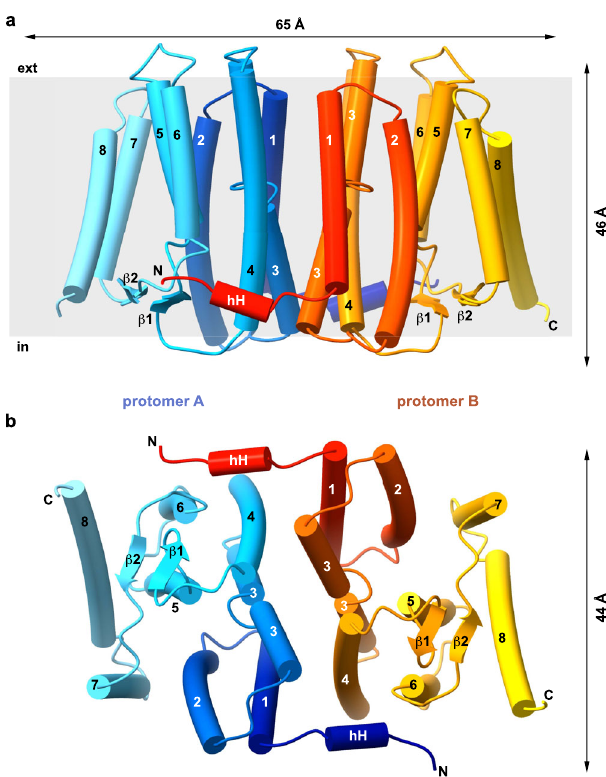
Fig. 2 Overall structure of MjPSS. Side view ( a ) and cytoplasmic view ( b ) of the MjPSS dimer. The dimensions of the molecule are indicated by the arrows above and on the right side of the molecule. Protomer A is coloured from blue (N terminus) to cyan (C terminus) and protomer B from red to yellow. The two termini with the short horizontal helix (hH) and the short β -sheet formed by β 1 and β 2 are located on the cytoplasmic side of MjPSS. The transmembrane helices are numbered from 1 to